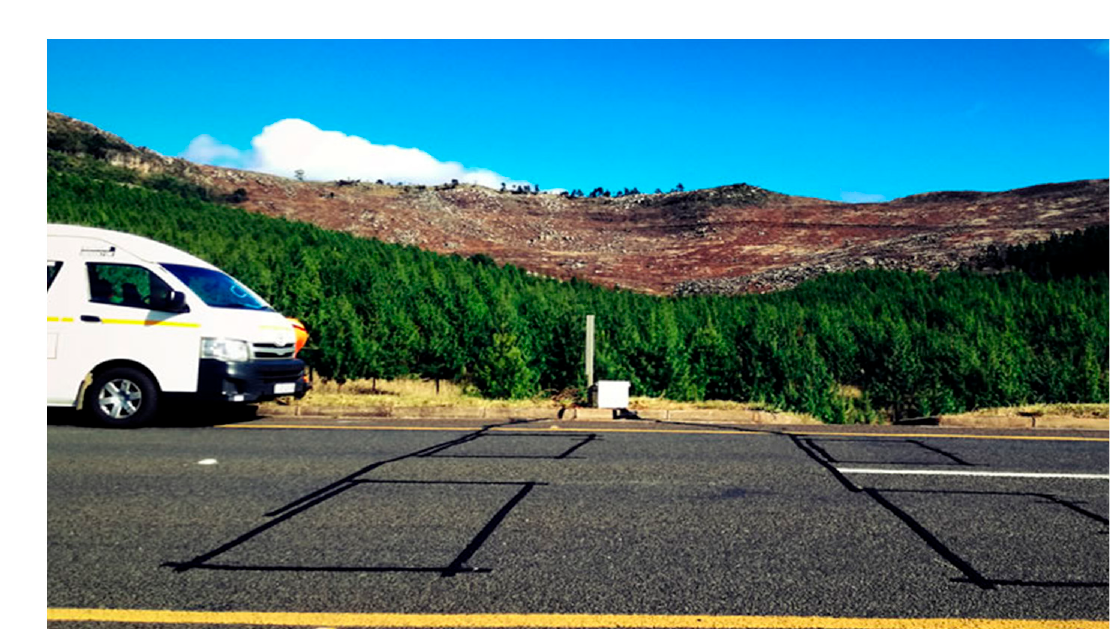
Figure 4. A road intersection in Johannesburg showing the data loggers beside the road.